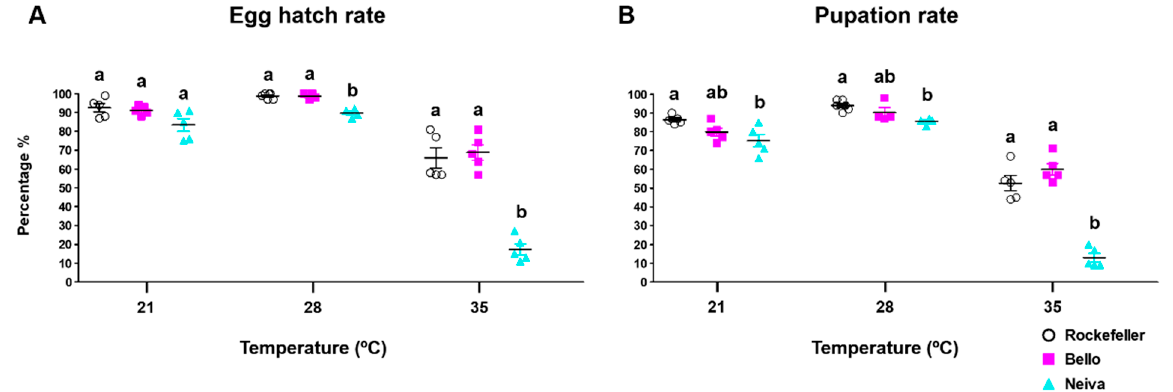
Figure 8. ( A ) Egg hatch rate and ( B ) pupation rate of two Colombian Ae. aegypti populations reared at 21 ± 1 °C, 28 ± 1 °C and 35 ± 1 °C temperatures, 80 ± 5% relative humidity, and 12 h light: 12 h dark photoperiod. The mean and standard error of the mean were plotted. Each point represents a replicate that started from a cohort of 100 eggs. The total number of replicates were: Bello and Neiva 28 ± 1 °C (4); control Rockefeller 28 ± 1 °C (6); Bello, Neiva and control Rockefeller 21 ± 1 °C and 35 ± 1 °C (5). One-way analysis of variance (ANOVA) was conducted, followed by a Bonferroni post-hoc test to account for multiple comparisons between Ae. aegypti populations at the same temperature. Populations sharing the same letters are not significantly different ( p > 0.05).